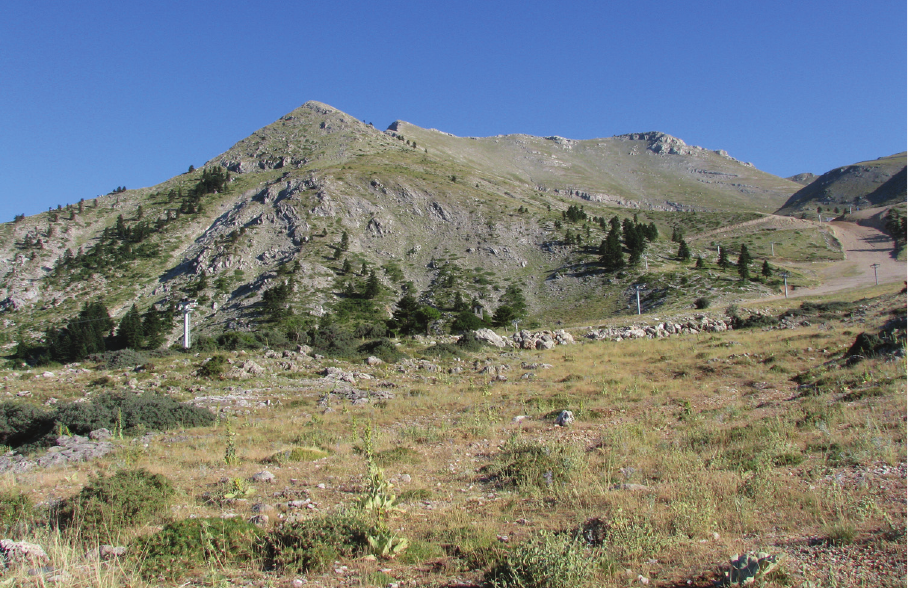
Figure 31. Habitat of P. aroaniensis in its type locality. Greece, Peloponnesse Peninsula, Mt. Chelmos, near Kalavrita, 1600 m, 16 July 2008. Photo by V.A.